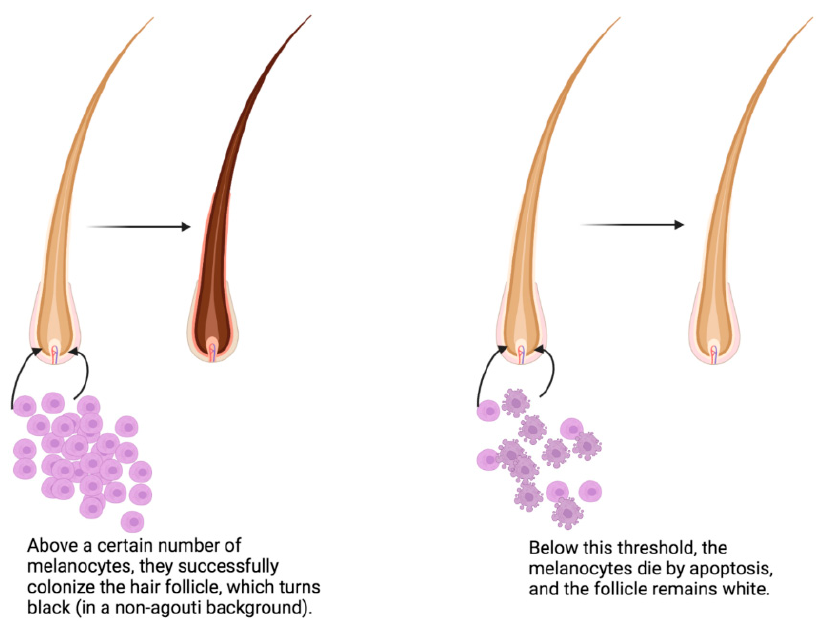
Figure 2. Below a certain number of melanocytes that are able to colonize the hair follicle, they die by apoptosis (right), leading to a white hair. Above this threshold, they survive, leading to a black hair. This results in a mixture of white and black hairs on the coat of the mouse. This figure was created using BioRender (https://biorender.com/, accessed on 1 July 2022).